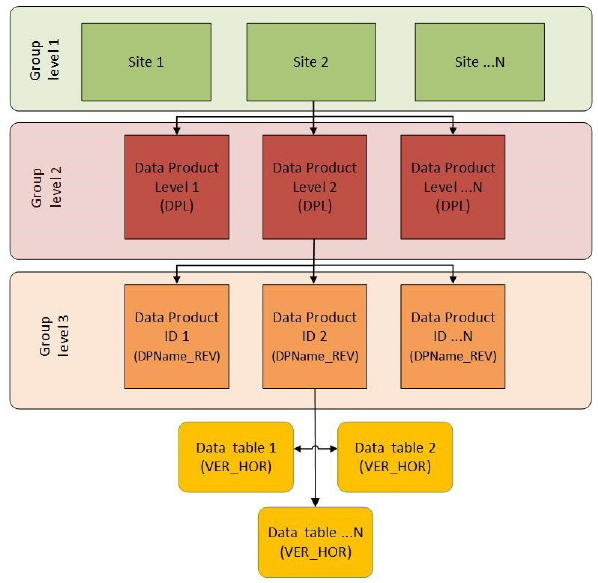
Figure 4. The NEON HDF5 file structure based on the NEON data product naming